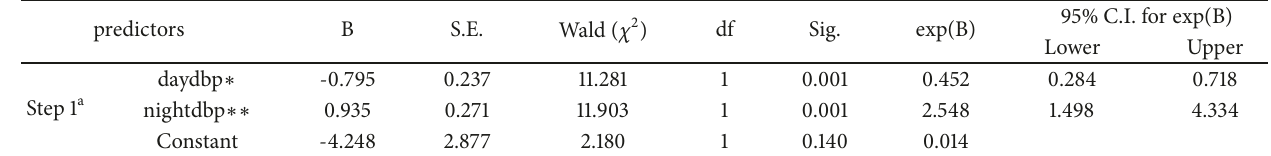
Table 6: Logistic regression analysis predicting dippers and nondippers from daytime and nighttime blood pressure.